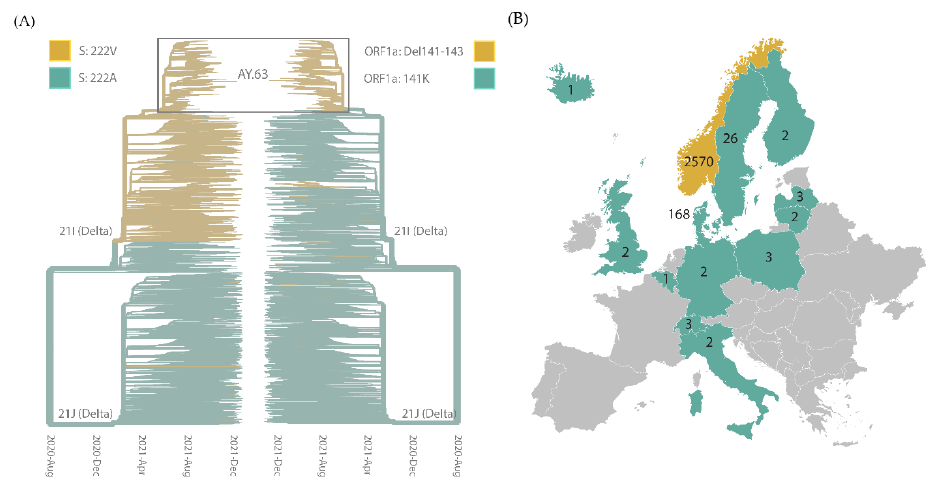
Figure 3. Phylogeny of the Delta lineage. ( A ) Phylogenetic analysis of Delta with the Pango lineage AY.63 and NextClade clade annotations indicated. The strains carrying the characteristic genetic signatures for AY.63, spike A222V (left tree), and ORF1a 141–143 deletions (right tree) are colored yellow. ( B ) The number of sequences with Pango lineage AY.63 published in GISAID drawn on their country of origin. In addition to the countries visualized here, there is also one sequence sampled from the USA published in GISAID. The map was adapted from Wikipedia.org, accessed on 10 October